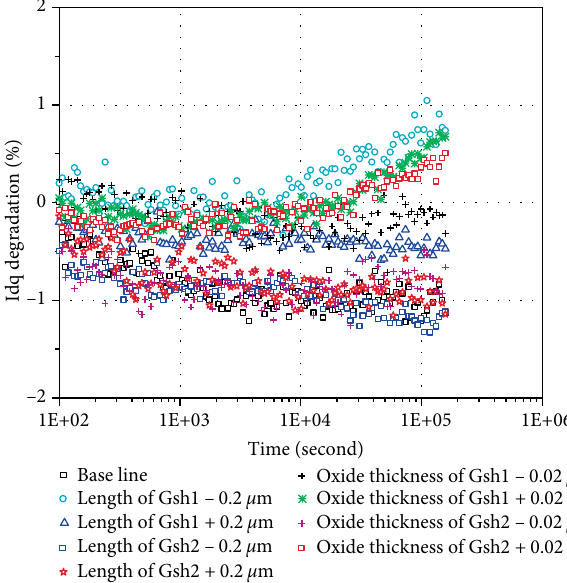
Figure 9: Static bias current degradation during HCI testing.